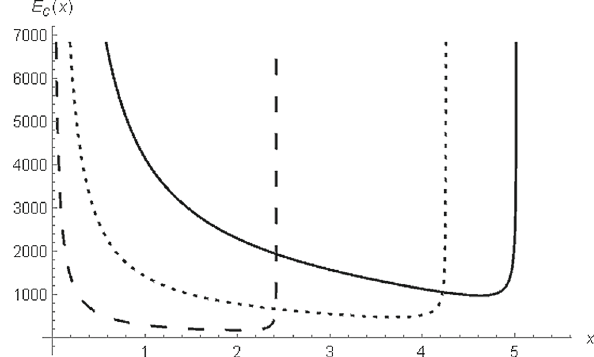
Fig. 6 Plot of the energy of the cubic configuration E c with respect to x . The dashed line corresponds to p = q = 1, the dotted to p = 2, q = 1 and the continuous line to p = 3, q = 1. The minimum of the energy in terms of the size of the cube l is: l = 0 . 322, l = 0 . 369 and l = 0 . 385